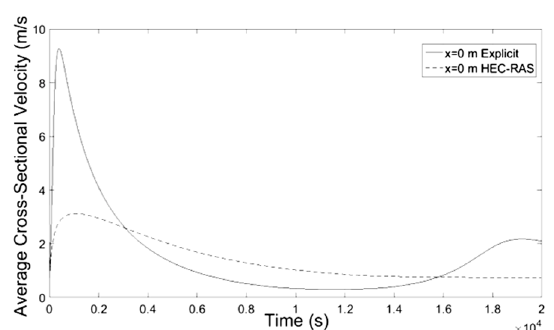
Figure 3. Average Velocity-Time at x = 0 m.